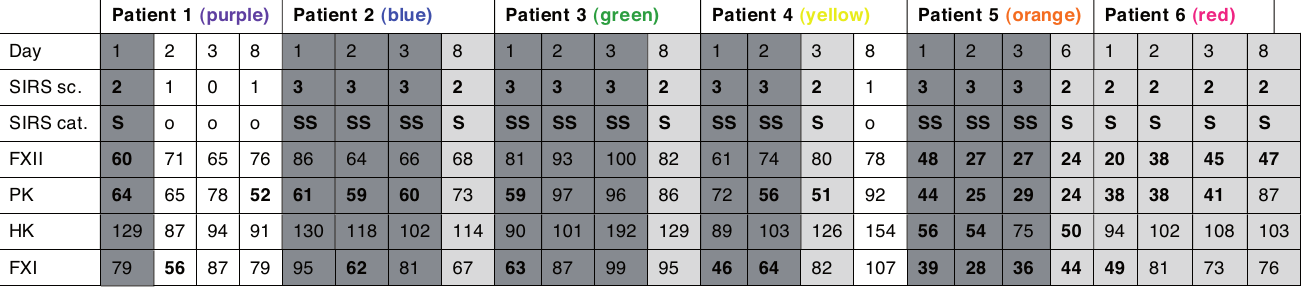
Standard parameters of CSA. Mann Whitney rank sum test. Abbreviations and comments: score (sc., SiRS score according to [22]), category (cat.): no SiRS (o, white) SiRS (S, light grey)), severe sepsis and/or septic shock (SS, dark grey), clotting factor activity for FXii (normal range: 61–145%), Pk (65–120%); Hk (65–140%) and FXi (65–140%); bold characters indicate pathological